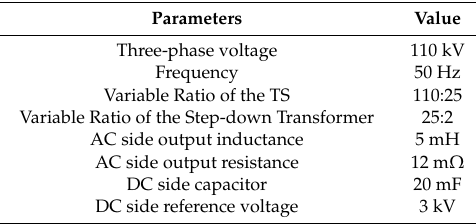
Table 2. Parameters of the system.